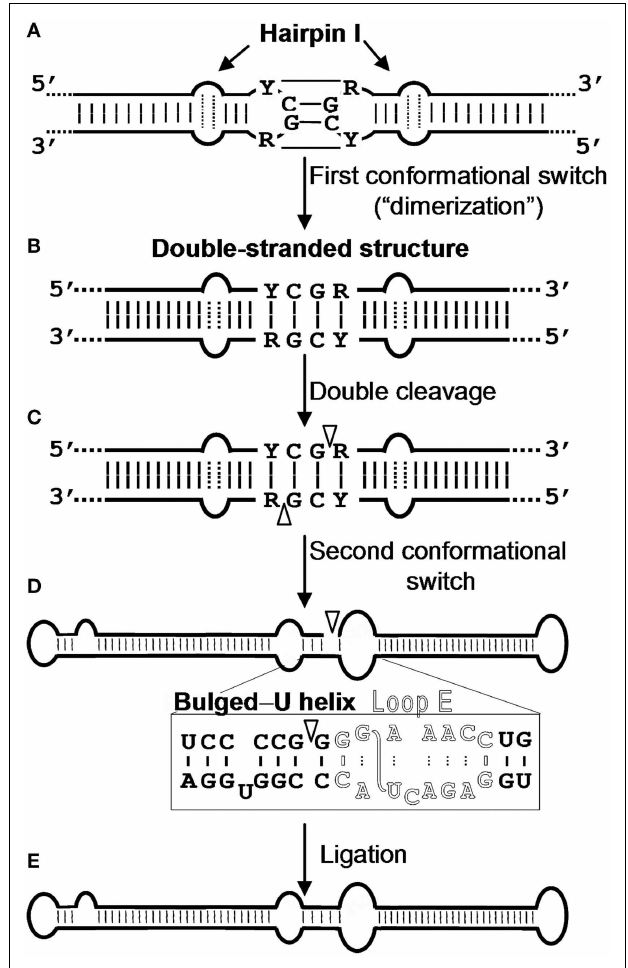
FIGURE 3 | Model for processing in vivo of the oligomeric ( + ) replicative intermediates of the family Pospiviroidae. The model predicts a kissing-loop interaction between the palindromic tetraloops of two consecutive hairpin I motifs (A) , with their stems then forming a longer interstrand duplex (B) .This double-stranded structure is the substrate for cleavage at specific positions in both strands (C) . Following a second conformational switch, the resulting unit-length strands adopt the extended rod-like structure with loop E (in outlined fonts) and the adjacent bulged-U helix (D) , which is the substrate for ligation (E) . R andY refer to purines and pyrimidines, respectively, the S-shaped line denotes the UV-induced cross-link, and white arrowheads mark the cleavage sites in the double-stranded structure and the ligation site in the extended conformation. Reproduced with permission from Gas et al.